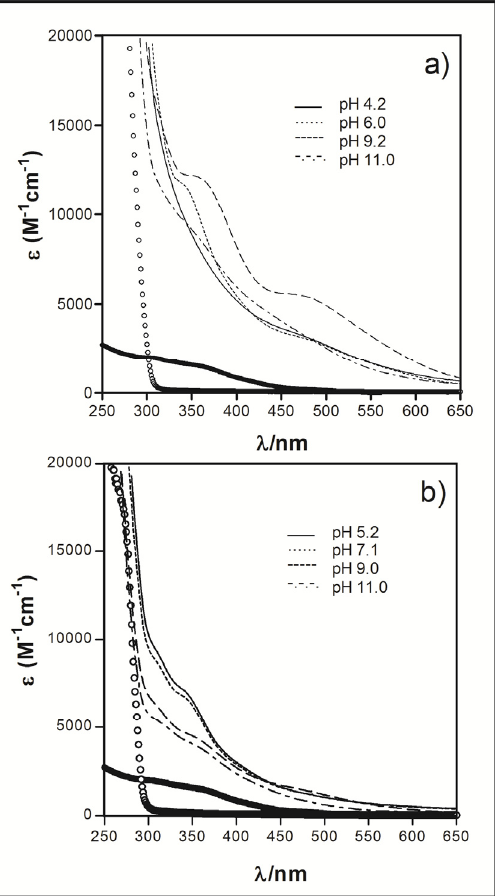
Figure 4. Solution electronic spectra of ( a ) Fe White and black circles spectra corresponded to unbound cyclophane and Fe(III) respectively, both at pH ~ 7, as a